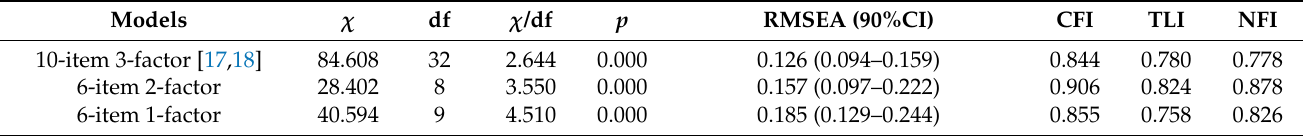
Table 3. CFA goodness-of-fit indices for the FAS models ( n = 104).